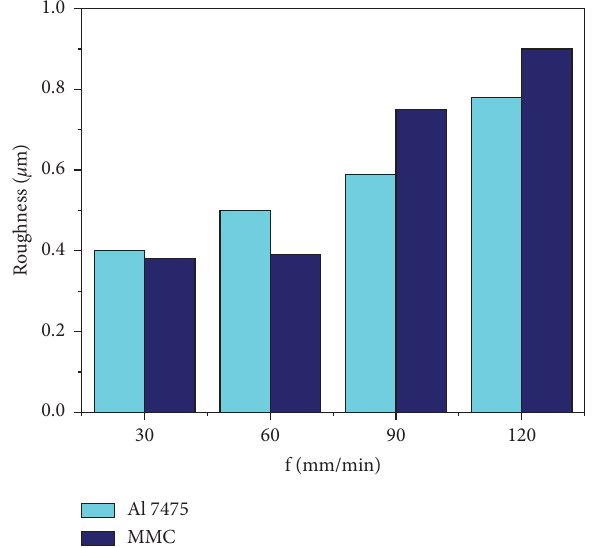
� 60 mm/min, a � 2mm). Figure a ( f p